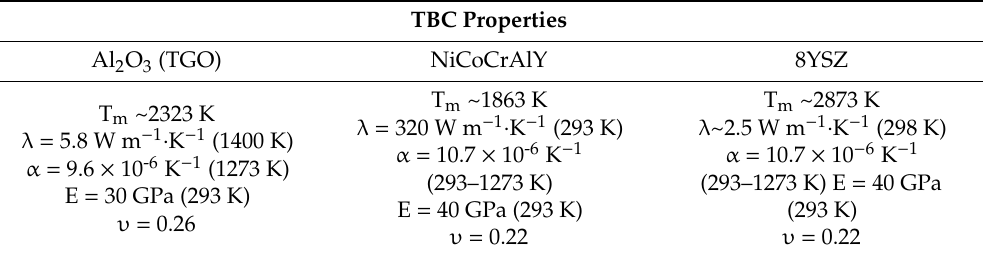
Table 1. Properties of thermal barrier coatings